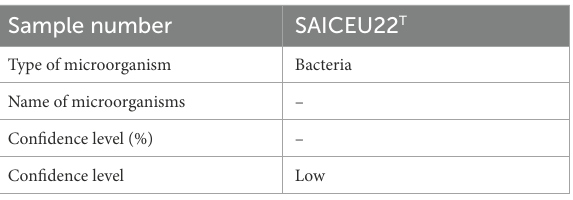
TABLE 12 Report of MALDI-TOF